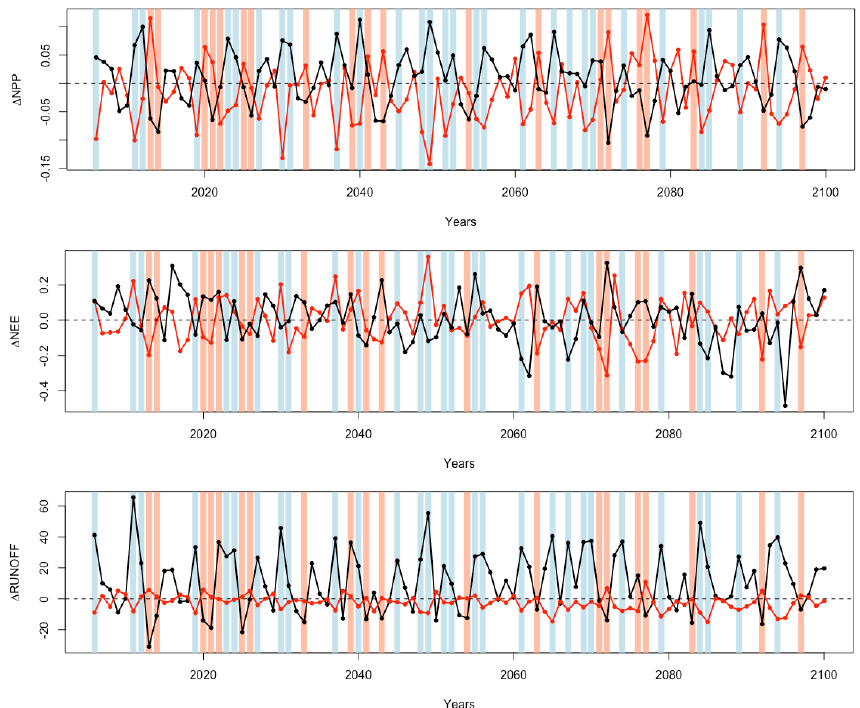
Figure 5. Temporal differences in the NPP, NEE, and RUNOFF according to future simulations with and without intensified ENSO contri- bution ( (cid:49) = with intensification − without intensification). Black line: northern transect; red line: southern transect. Vertical blue lines: all moderate ( < − 1 . 0 ◦ C) La Niña years identified for the future period (2006–2100); vertical pink lines: moderate ( > 1 . 0 ◦ C) El Niño years. The units are the same as Fig.